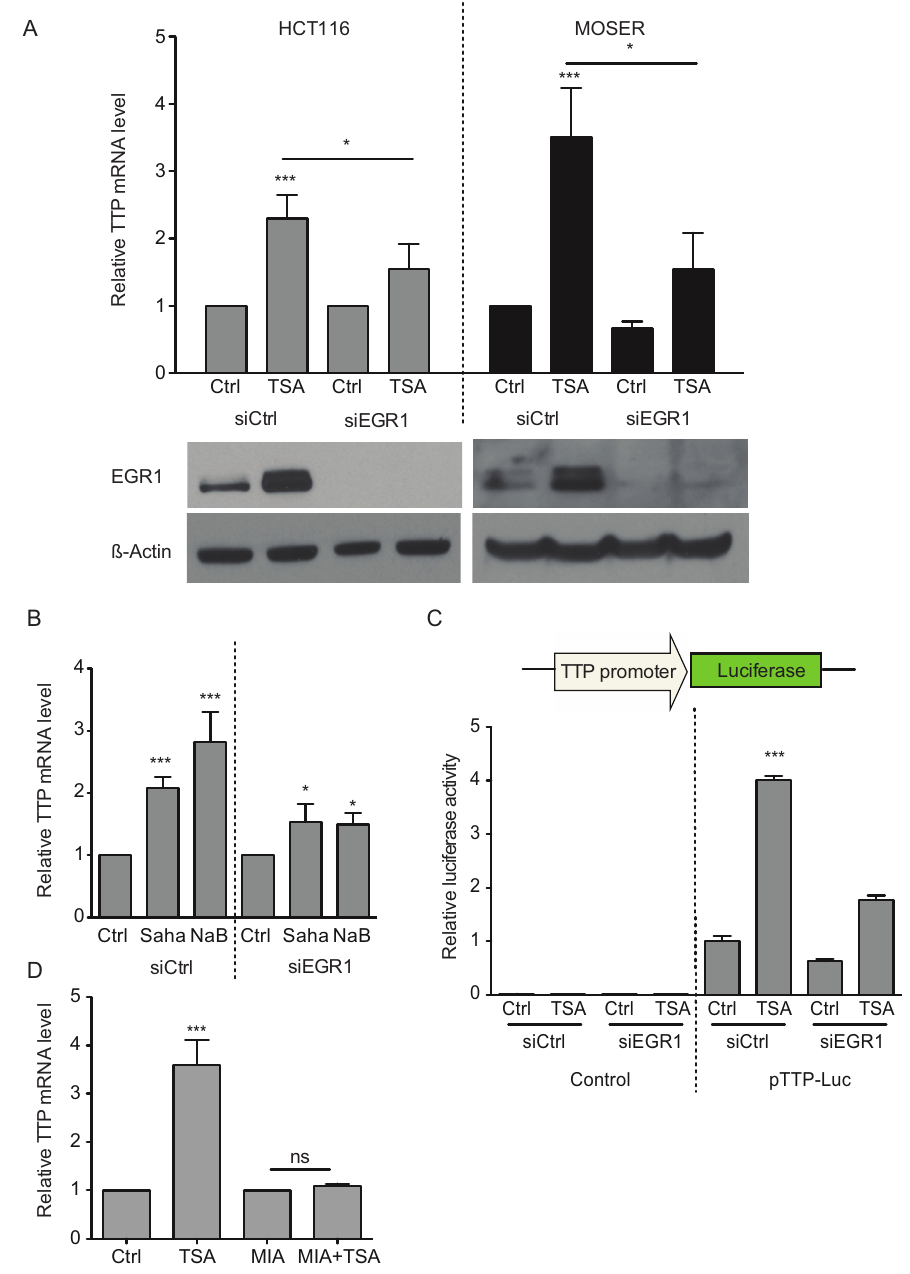
Figure 8. HDAC inhibitors induce TTP expression partially through EGR1. ( A ) HCT116 or Moser cells were transfected with 100 nM of control siRNA or siRNA against EGR1 for 24 h. Then the cells were treated with TSA (0.4 (cid:3)M) for 12 h. The expression of EGR1 was analyzed by Western blot and TTP expression was assayed by qPCR. ( B ) A similar experiment was performed in HCT116 cells treated with SAHA (5 (cid:3)M) or NaB (5 mM). ( C ) HCT116 cells were transfected with pTTP-Luc or control pGL3-Basic and a control siRNA or siRNA against EGR1 for 24 h. Cells were then treated for 12 h with TSA (0.4 (cid:3)M) and luciferase activity was measured. ( D ) HCT116 cells were treated 24 h with 500 nM of mithramycin A prior to 12 h of treatment with TSA (0.4 (cid:3)M). Expression of TTP was assayed by qPCR. Data represent the mean of three independent experiments (± SD). * p < 0.05, ** p < 0.01, *** p <